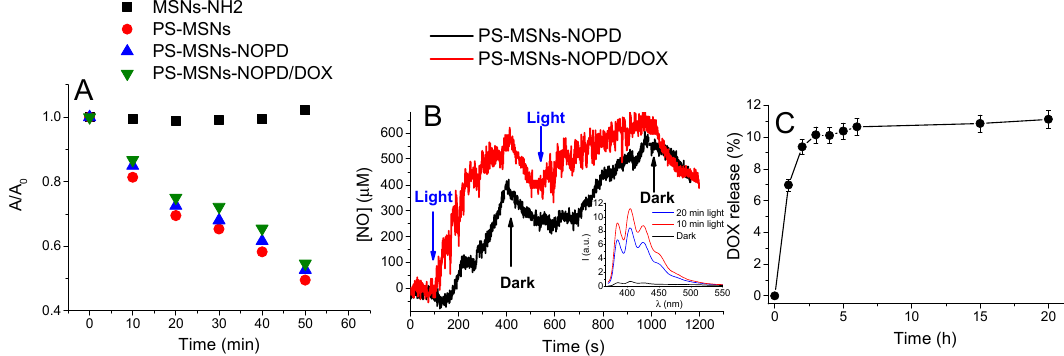
Figure 5. ( A ) A/A0 ratio at 440 nm of p -nitrosodimethylaniline/histidine (RNO) (17 µM) observed upon irradiation at 532 nm (50 mW) in the presence of different suspensions (1 mg mL − 1 ) of MSNs in PBS (pH 7.4, 10 mM). ( B ) NO release profile observed upon irradiation at 405 nm (100 mW) of different suspensions (1 mg mL − 1 ) of MSNs in PBS (pH 7.4, 10 mM). The inset shows the indirect e NO fluorimetric detection ( λ exc = 365 nm) (see experimental) observed for PS-MSNs-NOPD suspension (1 mg ml − 1 ) in the dark and after 10 and 20 min irradiation at 405 nm. ( C ) DOX release observed for PS-